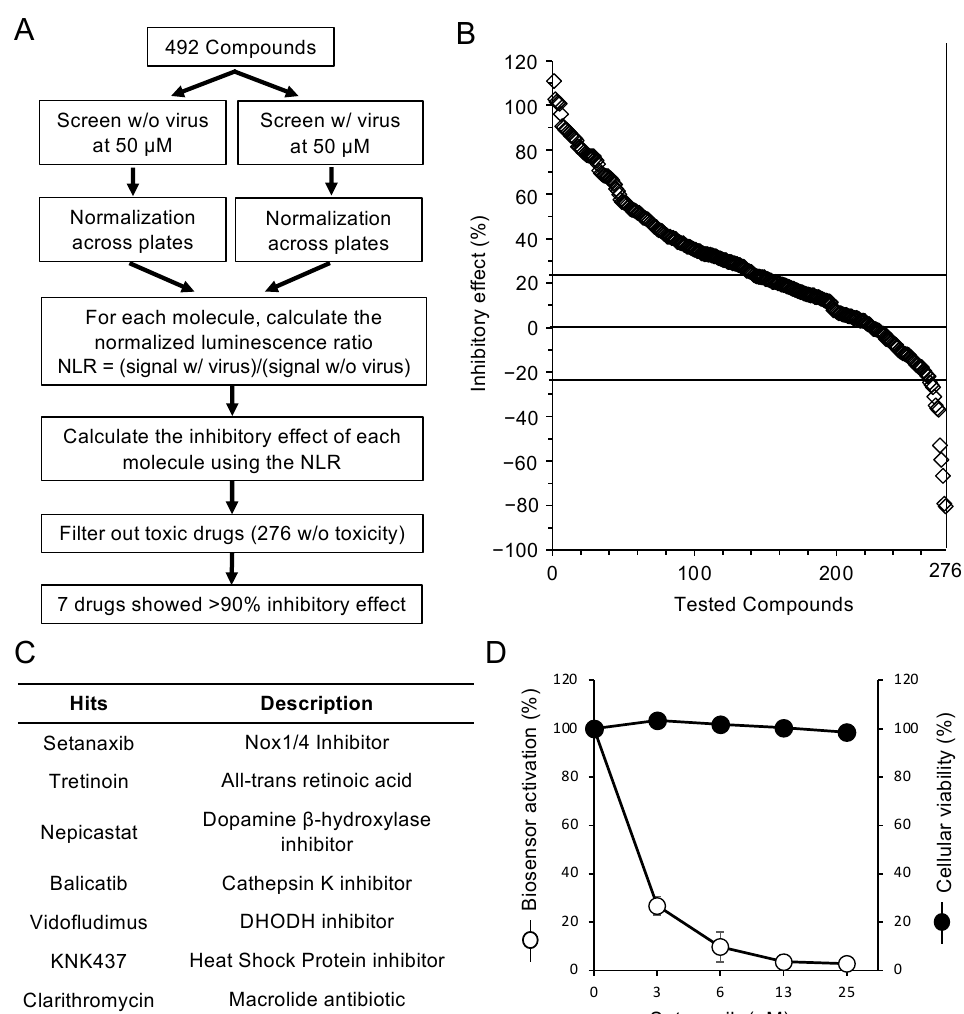
Figure 4. Identification of SARS-CoV-2 inhibitors by screening a chemical library of metabolic modulators. ( A ) Filtering pipeline for the selection of hit compounds. A total of 492 compounds were tested at 50 μ M on Huh7.5 expressing the luminescent biosensor for 3CL Pro . 20,000 cells per well were treated with the drugs for 24 h and then infected with SARS-CoV-2 (strain 2019-nCoV/USA_WA1/2020; MOI = 0.5; “screen w/ virus”) or were left uninfected (“screen w/o virus”). After 24 h, luciferase activity was determined and results were normalized across plates using DMSO-treated, uninfected control wells as reference. Activation of the luminescent biosensor upon SARS-CoV-2 infection was determined by calculating the normalized luminescence ratio (NLR = “luminescence w/ virus” over “luminescence w/o virus”), and results were expressed as a percentage of inhibitory effect compared to the DMSO-treated, infected control wells. Compounds showing no sign of cellular toxicity (see Section 2.4 for details) and inhibiting by 90% or more the activation of the luminescent biosensor in SARS-CoV-2 infected wells were selected. ( B ) Inhibitory effect of the 276 compounds showing no sign of cellular toxicity. Those with a negative inhibitory effect actually increased the activation of the luminescent biosensor upon SARS-CoV-2 infection. ( C ) List of the molecules selected from the screen. ( D ) Inhibitory effect of Setanaxib on the activation of the 3CL Pro biosensor by SARS-CoV-2. Experiment was conducted as in ( A ) but with increasing concentrations of Setanaxib and results were expressed as percentage of activity compared to the infected, untreated control. Data correspond to means ± SEM from one experiment in triplicate.